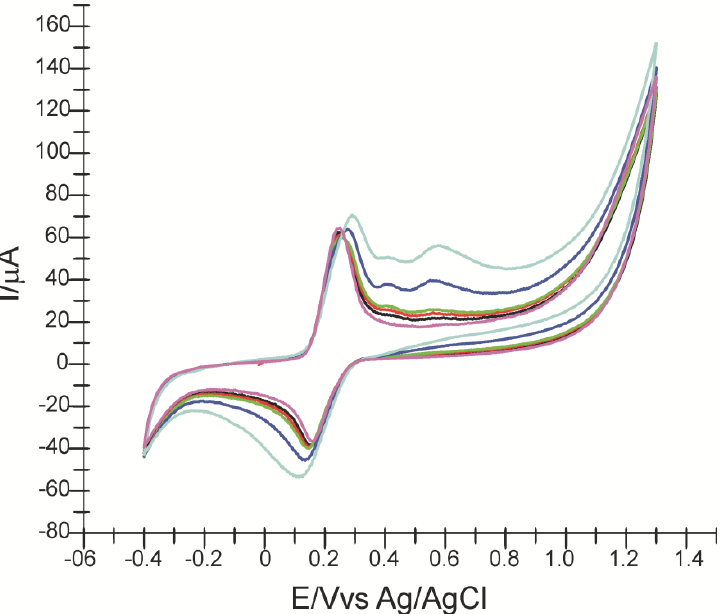
Figure 5. Cyclic voltammograms of CNF/SPE in 10 − 3 M caffeic acid solution (purple line), then containing different concentrations of ferulic acid: 10 µ M (black line), 50 µ M (red line), 100 µ M (green line), 500 μ M (blue line) and 1000 μ M (light blue line).